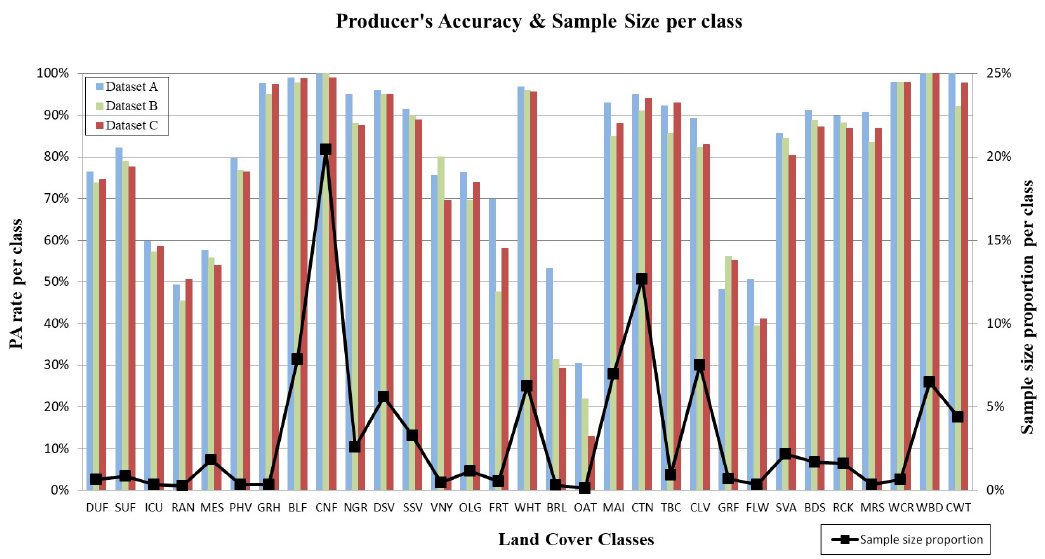
Figure 2. The resulting per-class PA rates (coloured vertical bars) for the RF experiments on Datasets A, B and C. The proportion of each class in the reference dataset, i.e., each class’s sample size, is also presented with the black line with